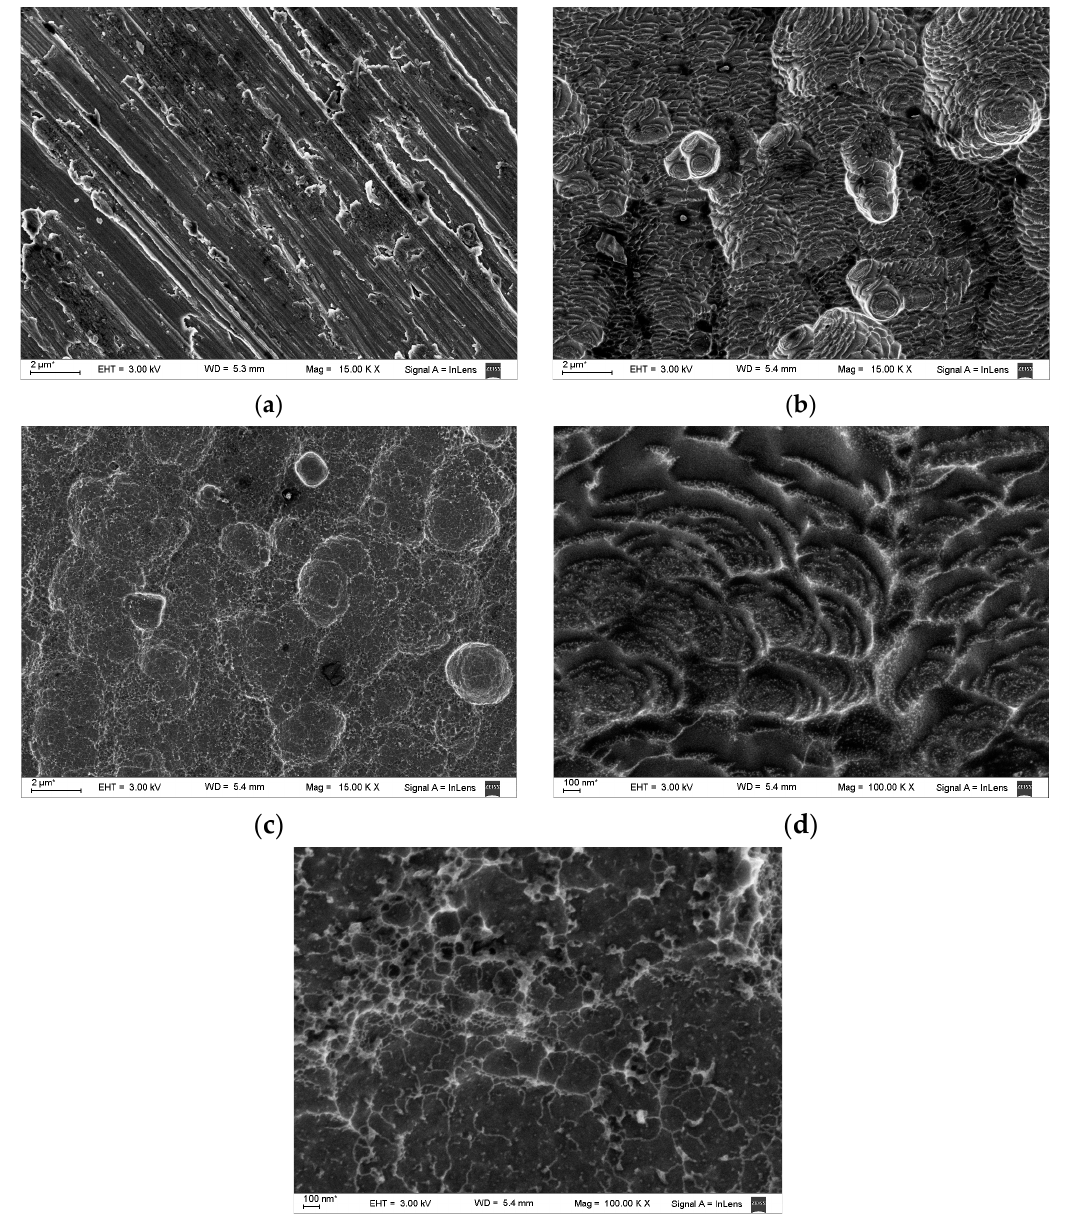
Figure 8. SEM images for ( a ) unexposed aluminum; ( b ) aluminum exposed to 0.1 M HCl without inhibitor and ( c ) aluminum exposed to 0.1 M HCl containing 0.248 g L − 1 of Ilex paraguariensis, after 48 h of immersion at 308 K; ( d ) aluminum exposed to 0.1 M HCl without inhibitor and ( e ) aluminum exposed to 0.1 M HCl containing 0.248 g L − 1 of Ilex paraguariensis, after 48 h of immersion at 323 K.